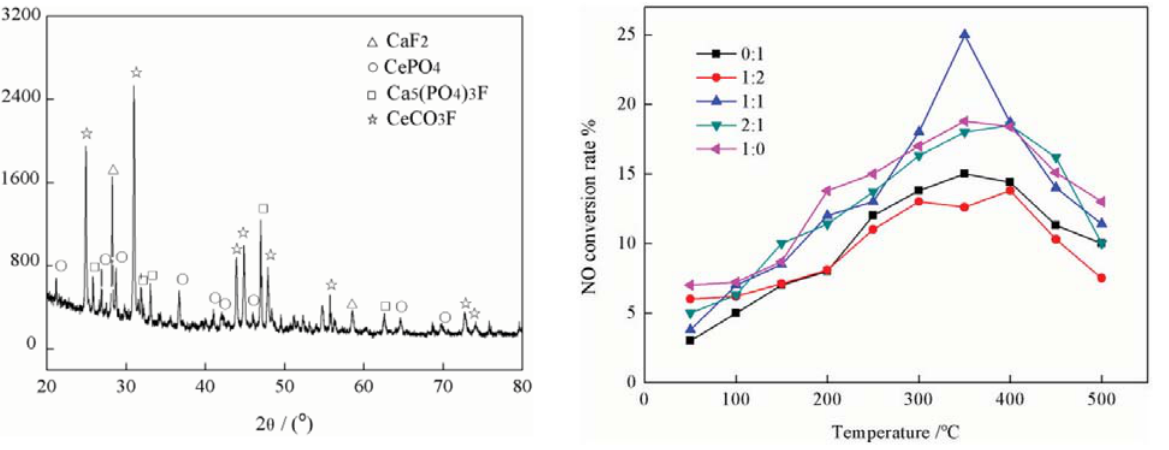
Figure 3: XRD of rare earth concentrates. Figure 4: Comparison the denitrification rate for different tailings and concentrates mixing